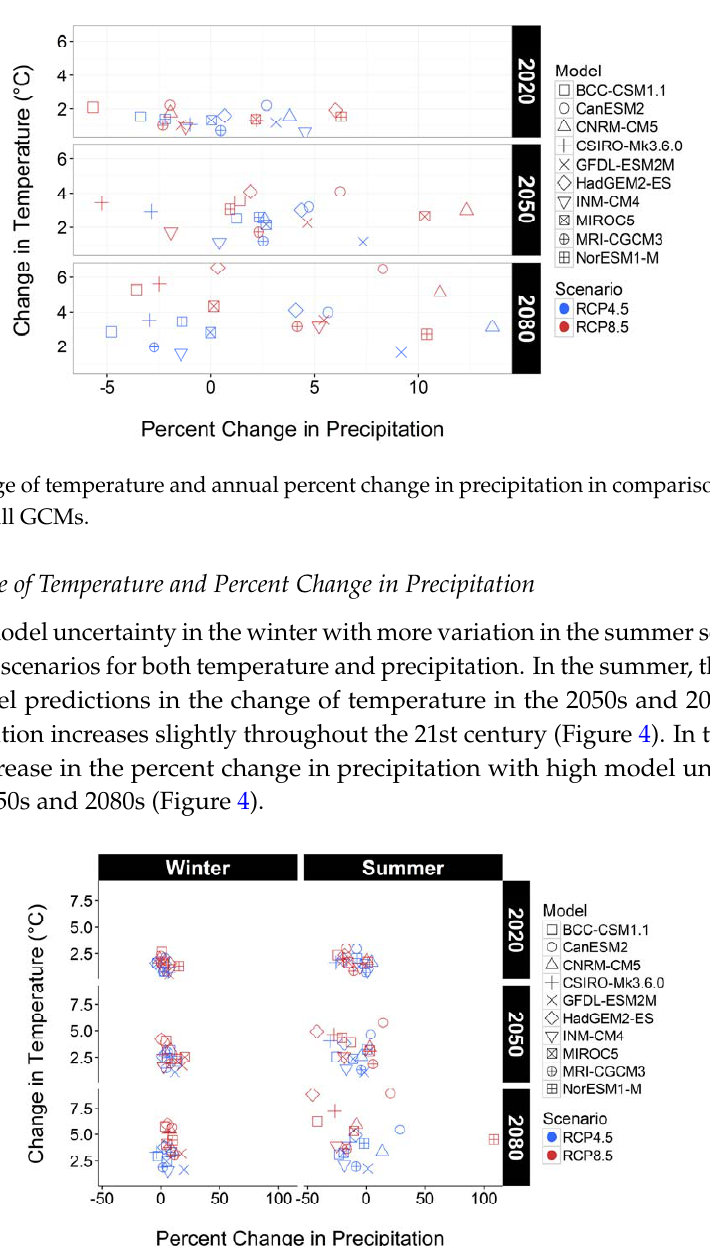
Figure 4. Change in seasonal temperature (T) and percent change in precipitation (P) for all GCMs in comparison to historical records. comparison to historical